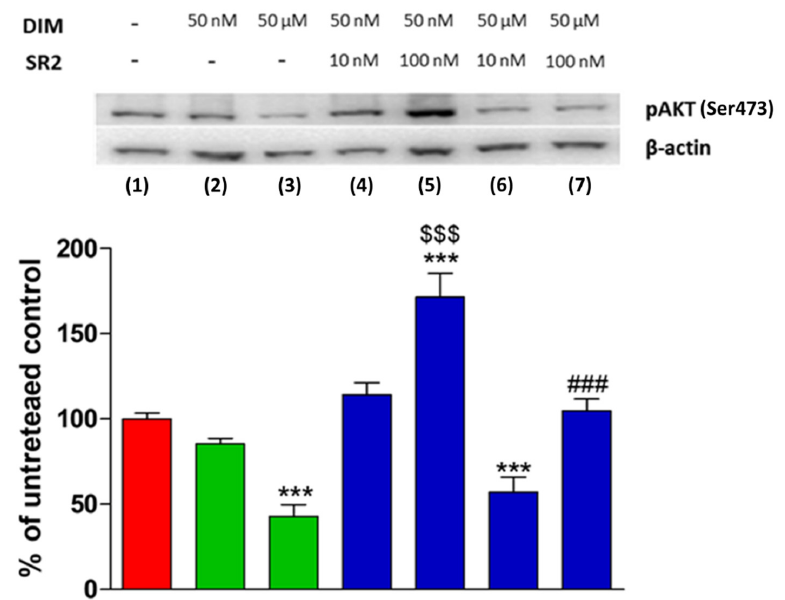
Figure 5. Western blot analysis of phosphor-AKT (Ser473) levels in PC3 cells. The effects of different concentrations of DIM alone and in the presence of different concentrations of the CB 2 receptor antagonist SR2 are shown. Levels are normalized to actin internal loading control and expressed as a percentage compared to untreated control cells. Each data point is the mean percentage value ± S.E.M. ( n = 3). *** p < 0.001 vs. CTRL (1), $$$ p < 0.001 vs. DIM 50 nM (2), ### p < 0.001 vs. DIM 50 μ M (3). (one-way ANOVA analysis of variance with Tukey’s post hoc analysis).